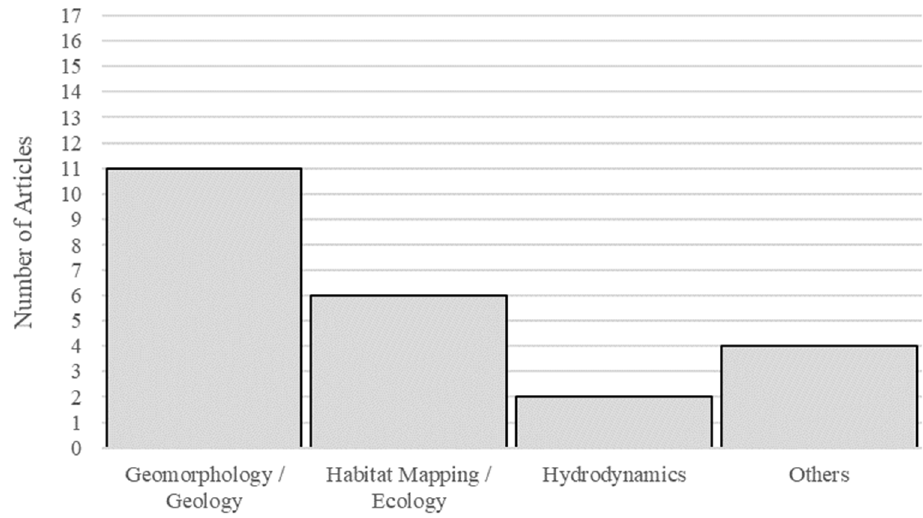
Figure 4. The categories of applications that were presented in the special issue. Some articles had multiple applications; for instance, when the geomorphology was interpreted and then used to map habitats.